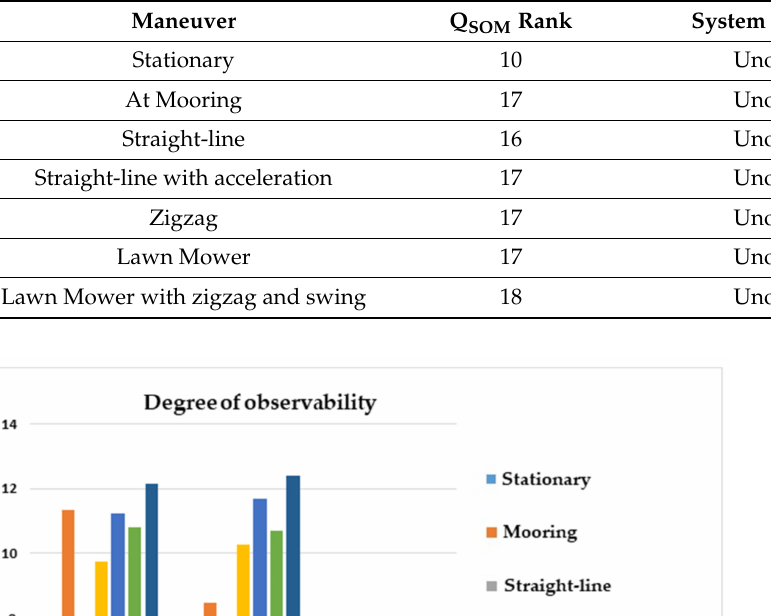
Table 2. Observability and final rank of Q SOM ( j = 100). INS/DVL/PS integration.